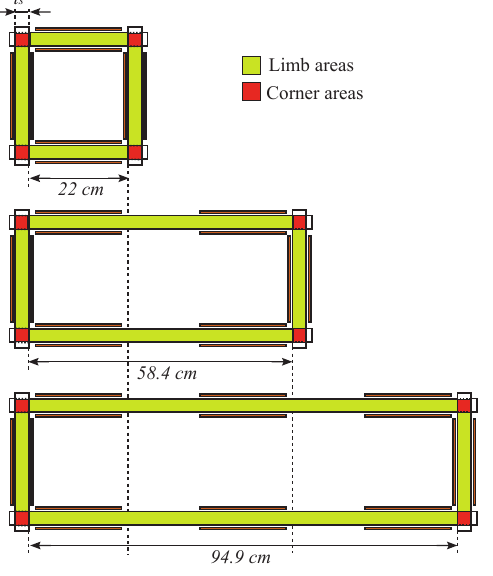
Figure 1. Schematic plan view of three frames. ( Top ) Short (standard Epstein frame); ( Middle ) Medium and ( Down ) Long.